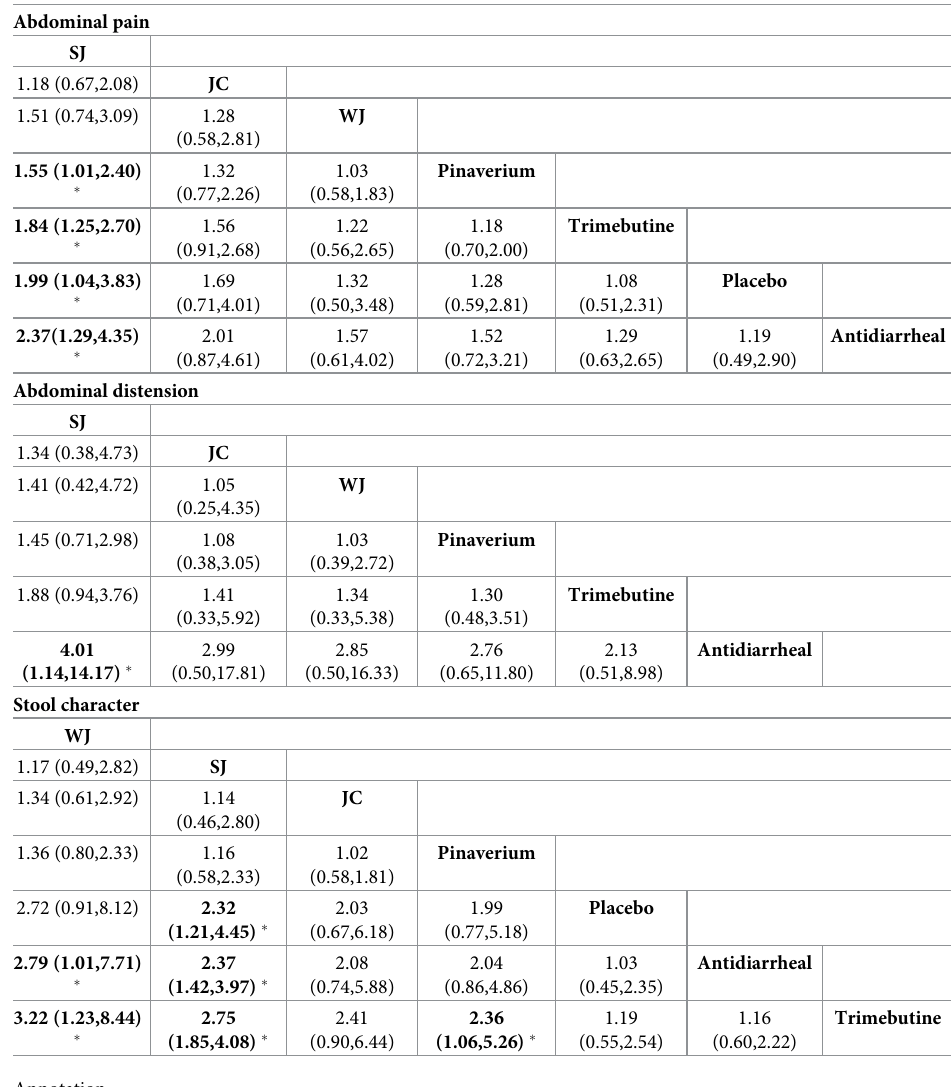
Table 6. Standard mean difference with 95% confidence interval of clinical